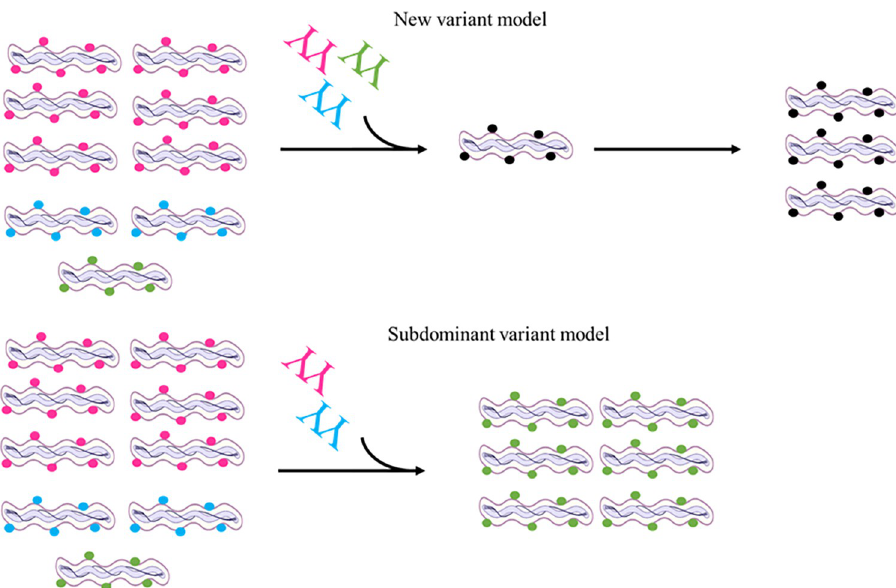
Fig 7. Hypothesized models for B . miyamotoi antigenic variation. The new variant model proposes that anti-Vmp antibodies eliminate the corresponding serotypes expressing those Vmps resulting in antigenic switching by gene conversion to generate a new Vmp serotype population. The subdominant variant model proposes that anti-Vmp antibodies eliminate the corresponding serotypes expressing those Vmps, but has no effect on a variant population that subsequently